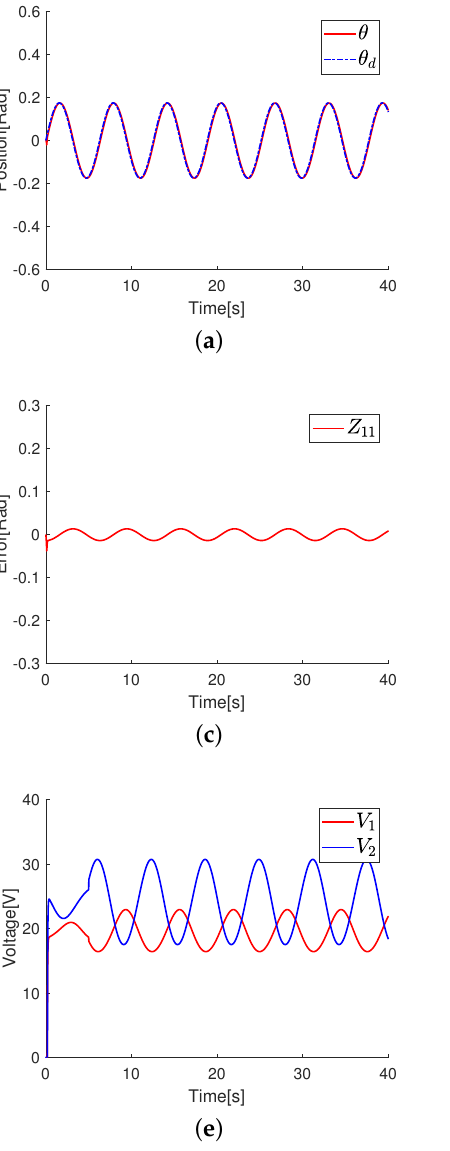
Figure 3. The control performance under the proposed control. ( a ) Tracking trajectory diagram of θ . ( b ) Tracking trajectory diagram of ψ . ( c ) Tracking error diagram of θ . ( d ) Tracking error diagram of ψ . ( e ) The input signals of the 2-DOF helicopter